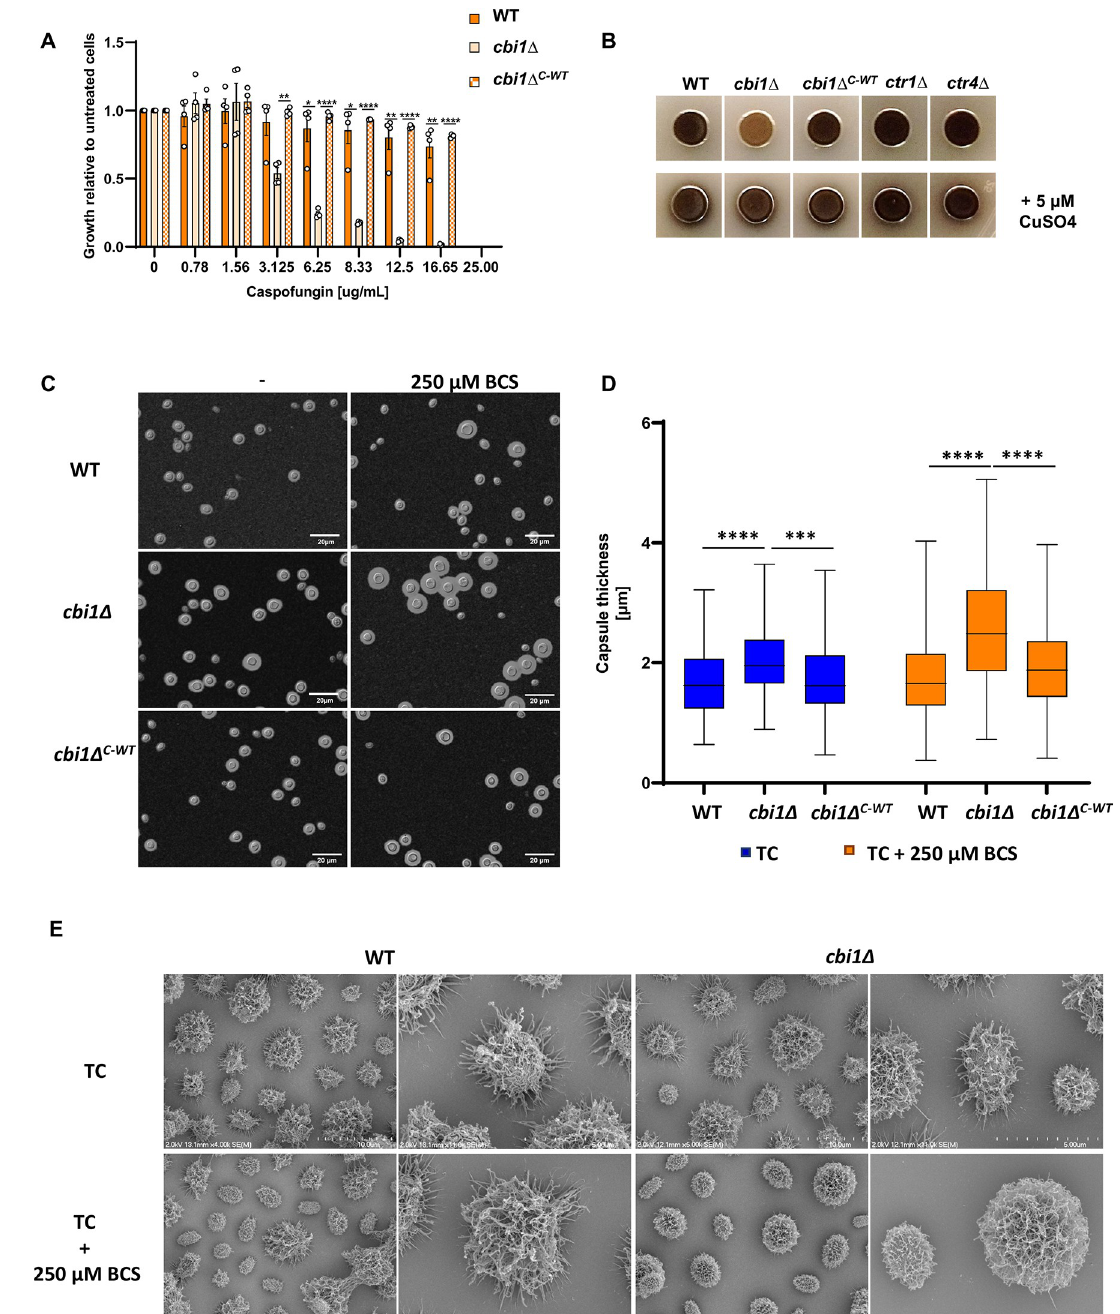
Fig 6. Cbi1 depletion and copper deficiency impacts cell wall-associated virulence phenotypes. (A) Minimal inhibitory concentration (MIC) analysis of caspofungin during copper deficiency. WT, cbi1 Δ and cbi1 Δ C-WT strains were grown in 96-well liquid cultures in SC media supplemented with 100 μ M BCS and were serial dilutions of caspofungin. OD 600 was measured after 24h of growth at 30˚C and the OD 600 of the non-treated condition was set to 1. Presented is the mean +/- SEM of 4 independent experiments. A 2-way ANOVA was performed from log transformed data using GraphPad Prism. (B) Melanization of WT, cbi1 Δ , ctr1 Δ and ctr4 Δ cells in the absence and presence of 5 μ M CuSO 4 . Overnight cultures were harvested, washed 1x with PBS, diluted to OD 600 2.5 and spotted on to L-DOPA plates to induce melanin production. Shown are representative images from 3 independent experiments. (C) Analysis of capsule formation using India ink counter-staining of WT, cbi1 Δ , and cbi1 Δ C-WT complemented cells. Indicated strains were grown for 3d in capsule inducing conditions in presence and absence of 250 μ M BCS. Cell were harvest, resuspended in PBS, stained with India ink (1,1) and analyzed using DIC optics. Shown are representative images from 3 independent experiments. Scale bar 20 μ m. (D)